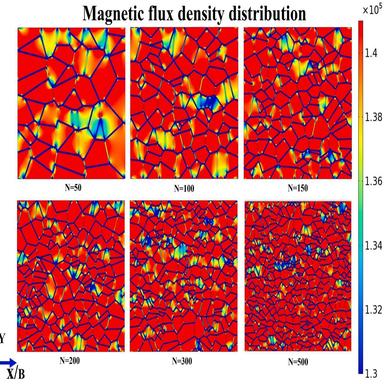
Magnetic flux density distribution of 2D FE model with different grain numbers.